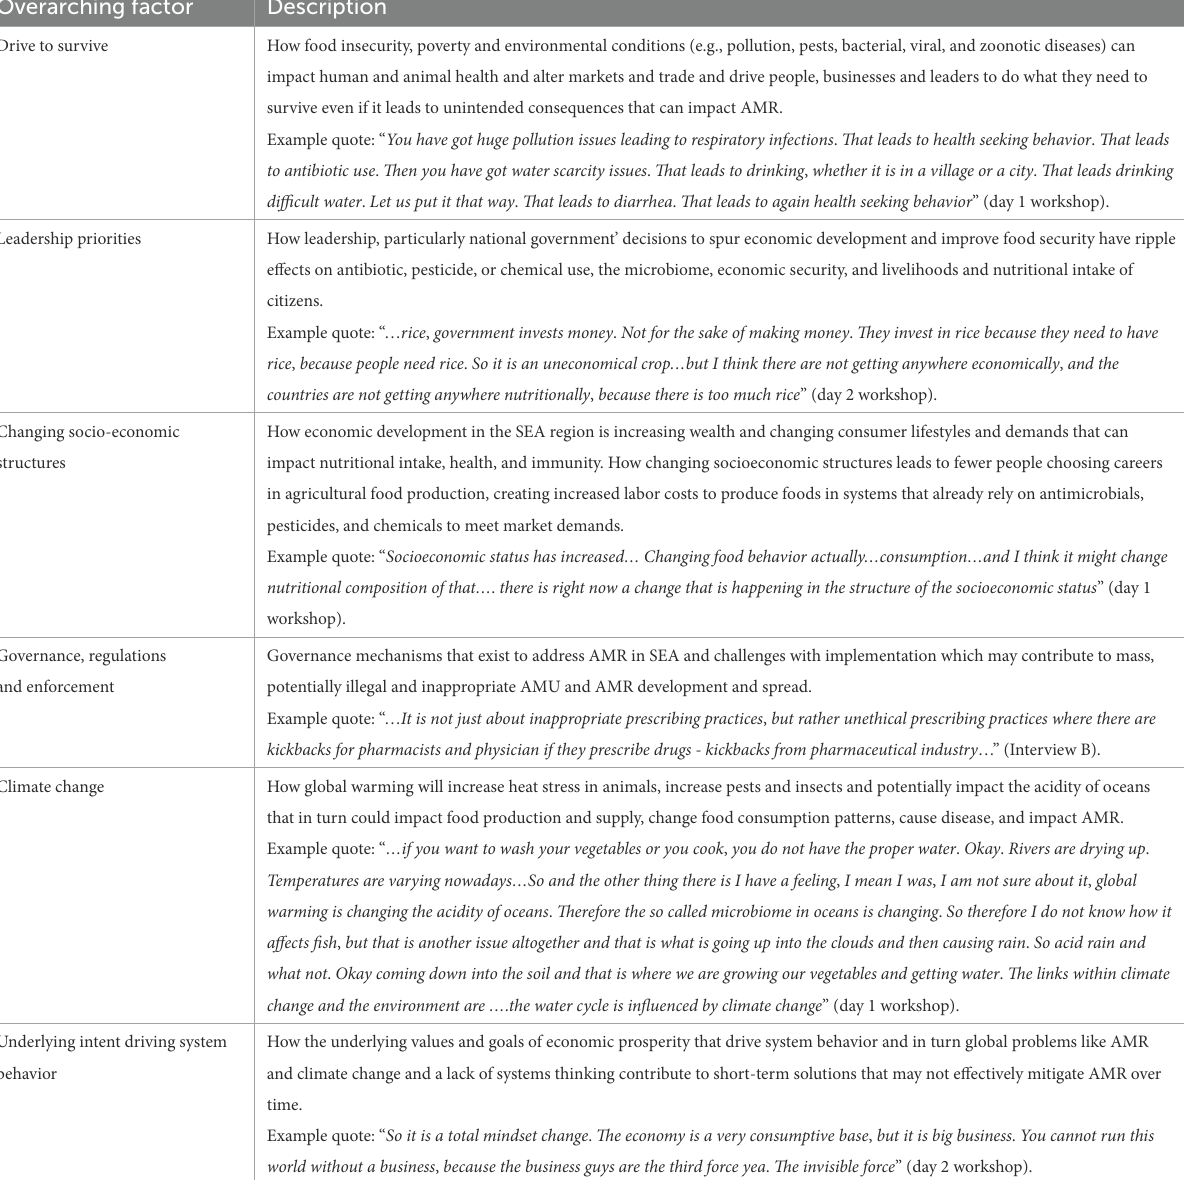
TABLE 2 Overarching factors based on participant